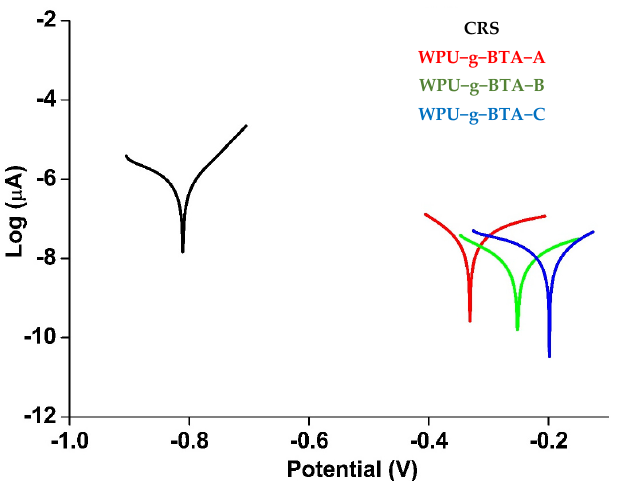
Figure 3. Tafel plots for raw CRS electrode and CRS electrode coated with WPU − g − BTA − A, WPU − g − BTA − B, and WPU − g − BTA − C, in 3.5 wt% NaCl (aq) for 30 min immersion.